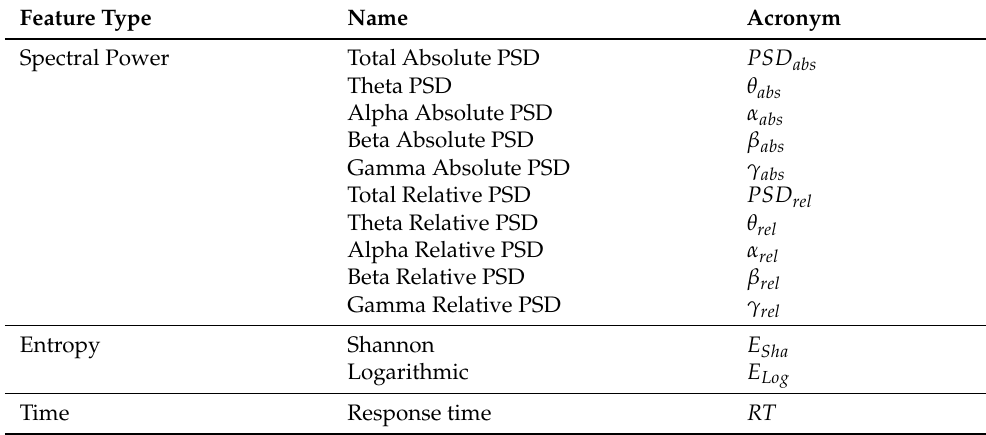
Table 2. Features used to characterise the EEG